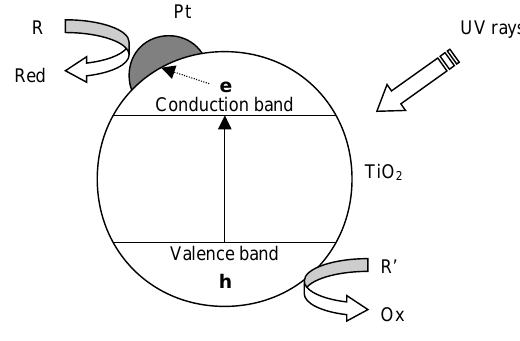
Fig. 2 Structure of Pt-carrying TiO 2